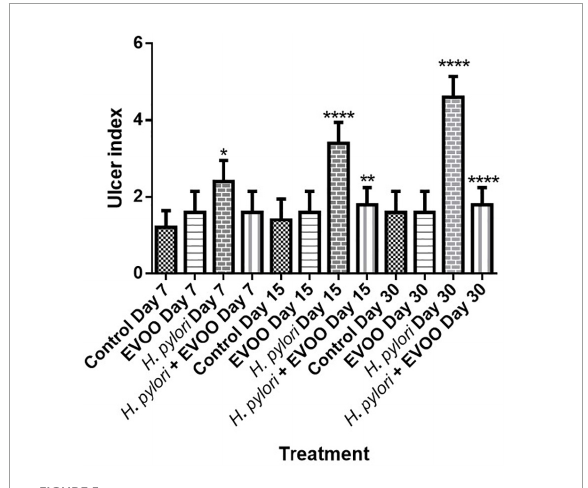
FIGURE5 Effects of extra virgin olive oil (EVOO) on gastric lesions induced by the infection of Helicobacter pylori in mice. Asterisks denote significant differences between groups (* p < 0.05, ** p < 0.01, and **** p < 0.001). All values are expressed as mean ± S.E.M.